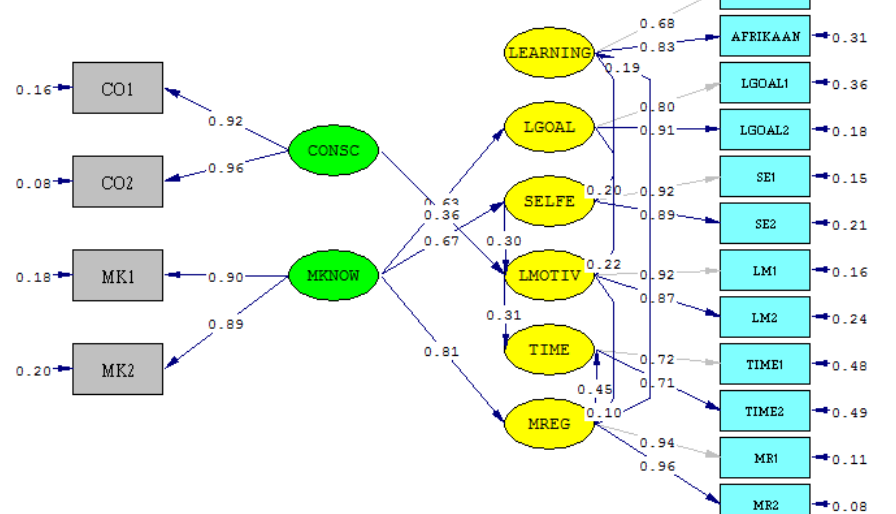
Figure 3: Representation of the modified Van Heerden-De Goede learning potential structural